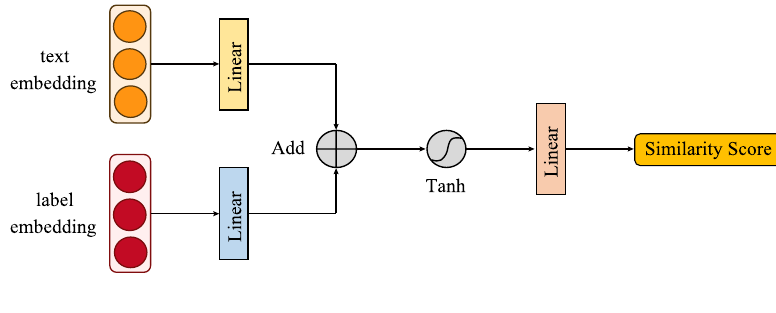
Fig. 5 Attention mechanism for generating the simulated label